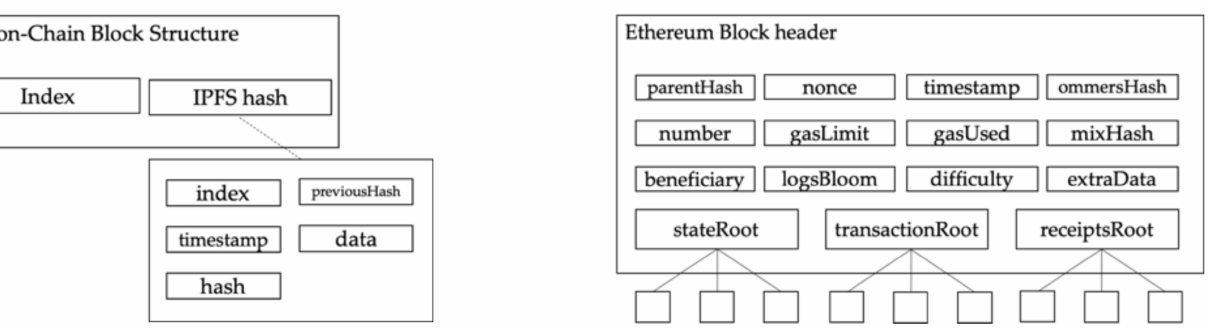
Figure 4. Block structure comparison: Fusion Chain vs